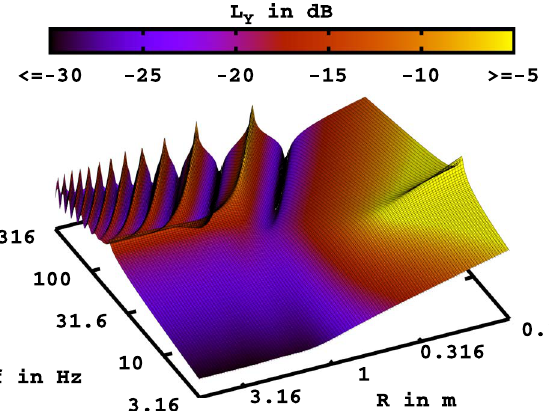
Figure 19. Level of admittance L Y according to (56); cyan marker lines for f 1 and f 2 ; r = 1.0 (cid:5) 10 4 Pa s/m 2 .